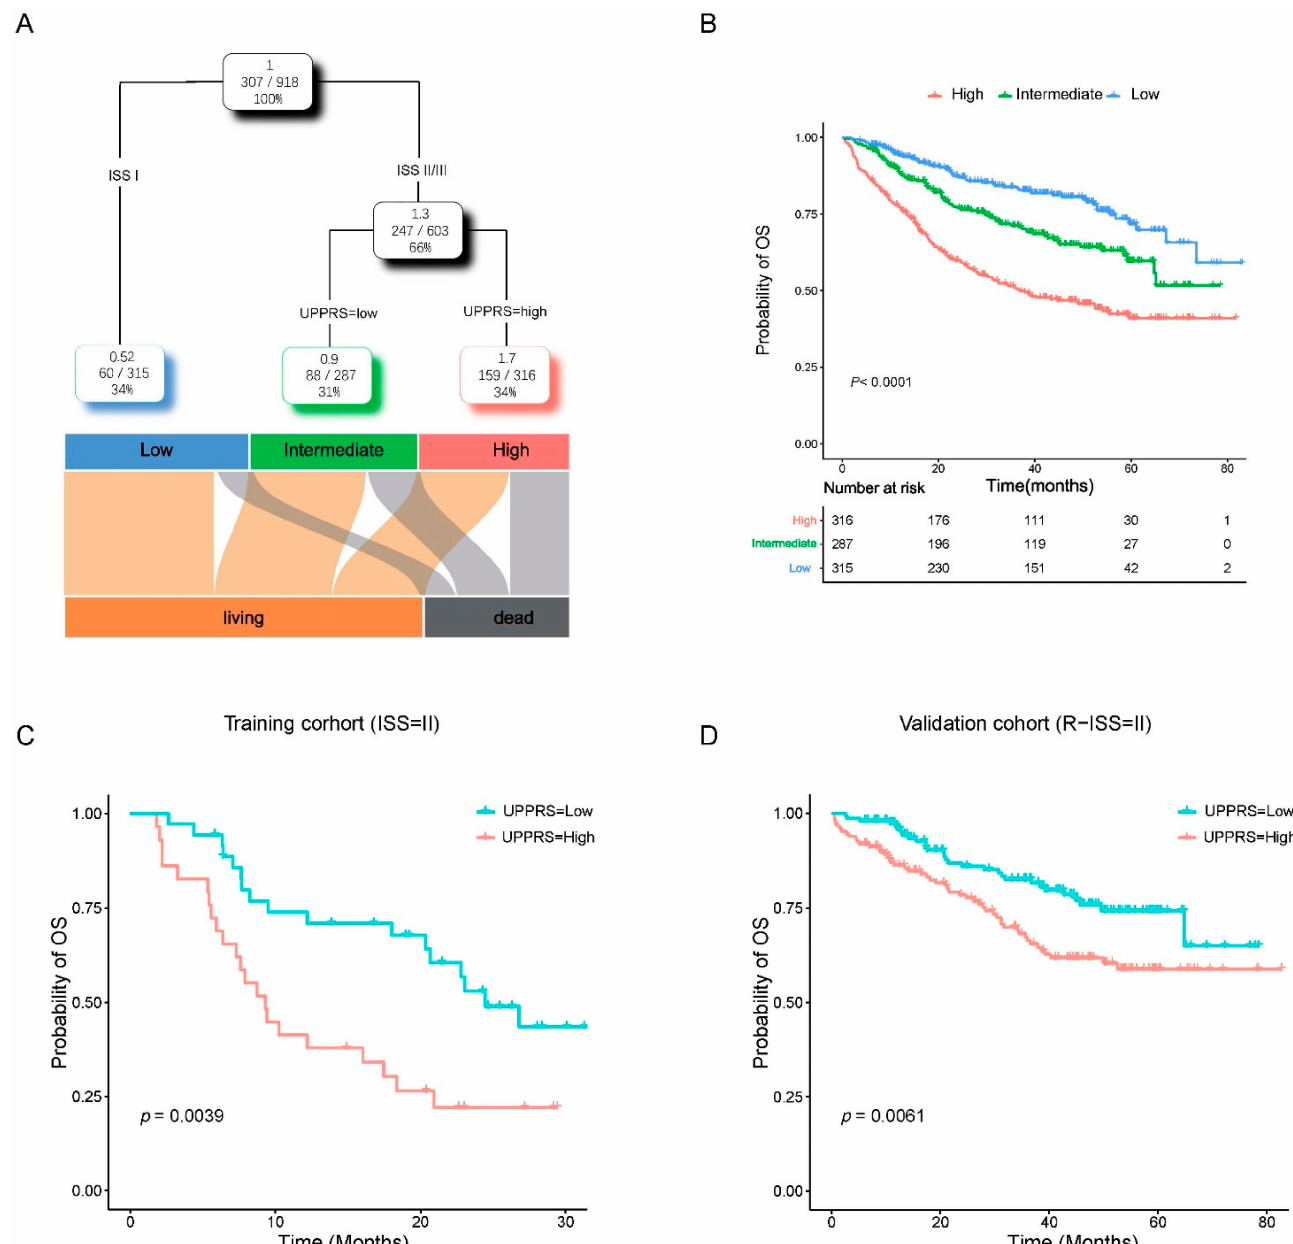
Figure 5. Combination of the UPPRS and ISS improves risk stratification in MM patients. ( A ) A decision tree was developed to stratify MM patients’ risk. ( B ) Performance of decision tree. ( C ) Kaplan–Meier curve for the UPPRS in ISS = II patients in the training cohort. ( D ) Kaplan–Meier curve for the UPPRS in R-ISS = II patients in the validation